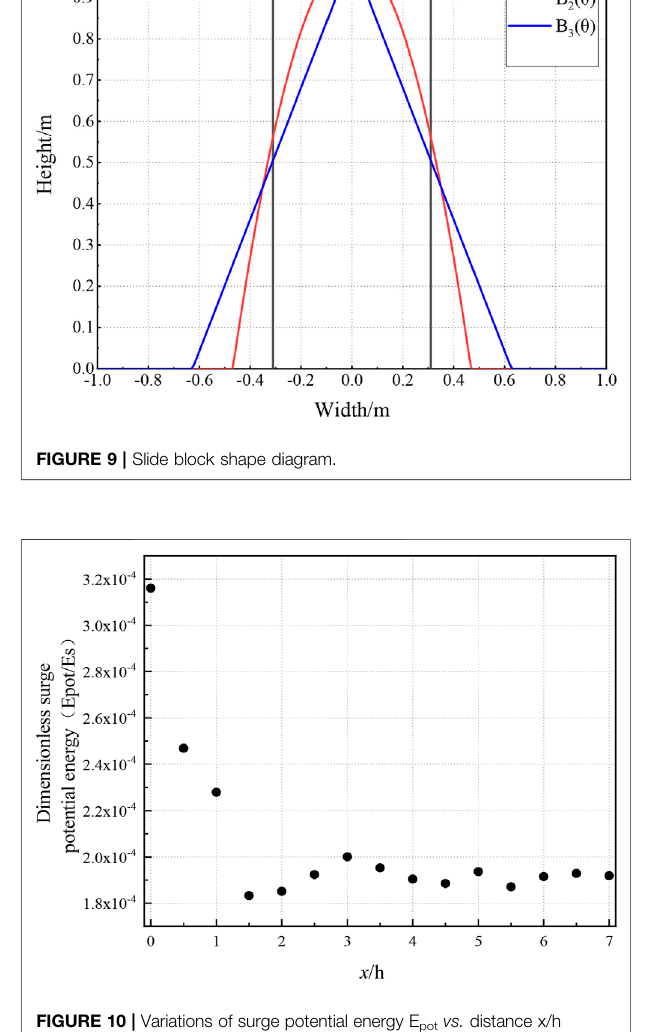
FIGURE 12 | Near- fi eld surge time-history curves.